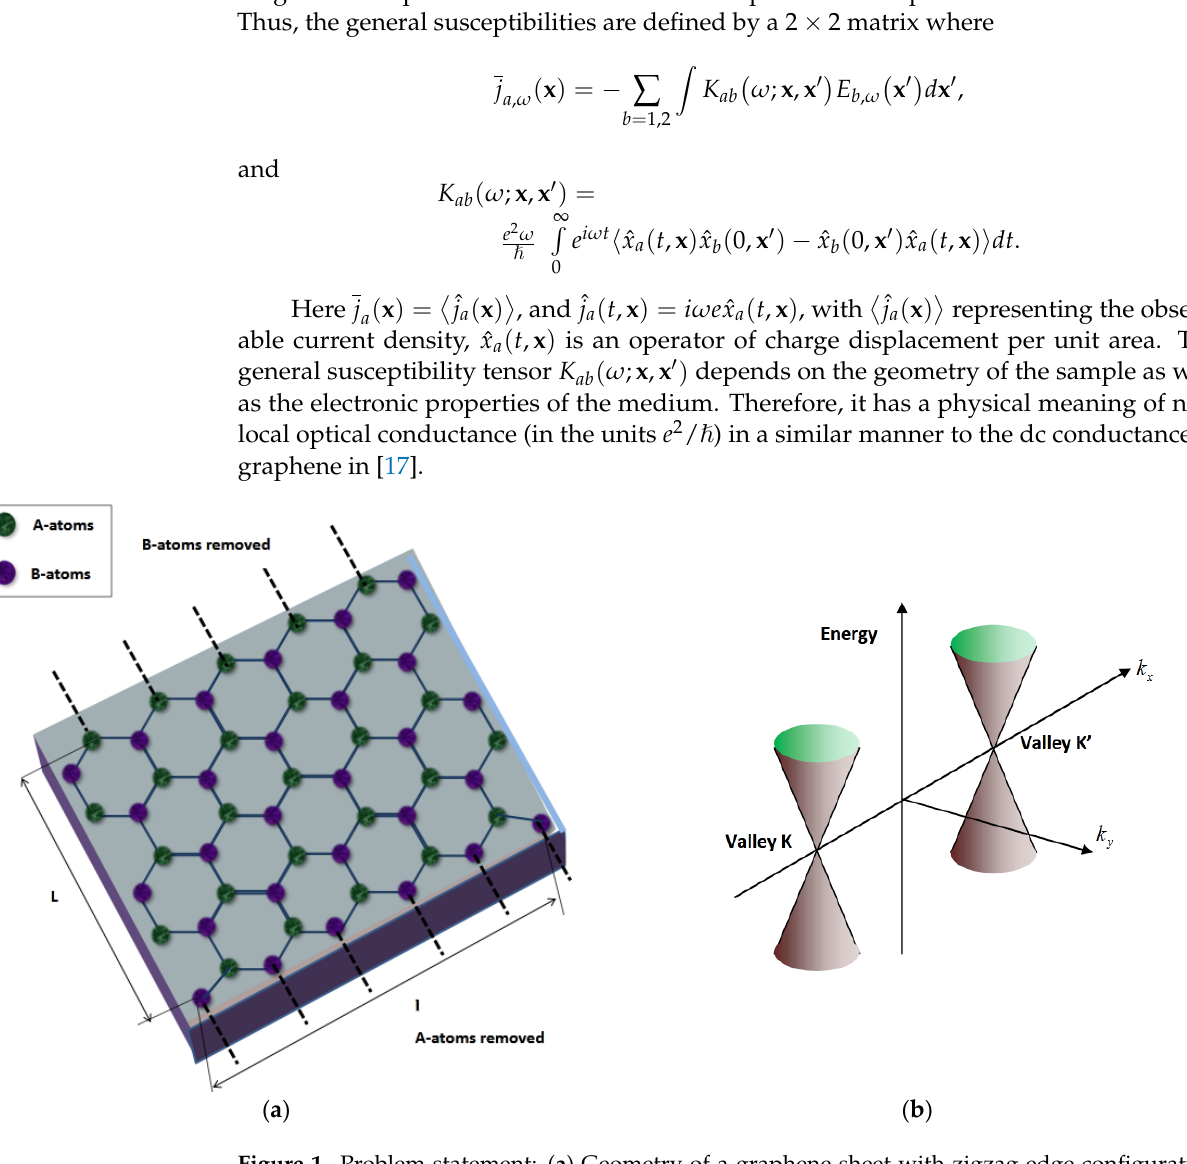
Figure 1. Problem statement: ( a ) Geometry of a graphene sheet with zigzag edge configuration. A-atoms and B-atoms form two sub-lattices coupled in every spinor modes. Zigzag edges produced via removing A- or B-atoms out of the sheet at the edge (the places of removed atoms are marked via dash lines); ( b ) Fermi–Dirac conical valleys for the model of pseudo-spin dispersion. The self-crossing points K and K (cid:48) correspond to the pair of Fermi points in the Brillouin